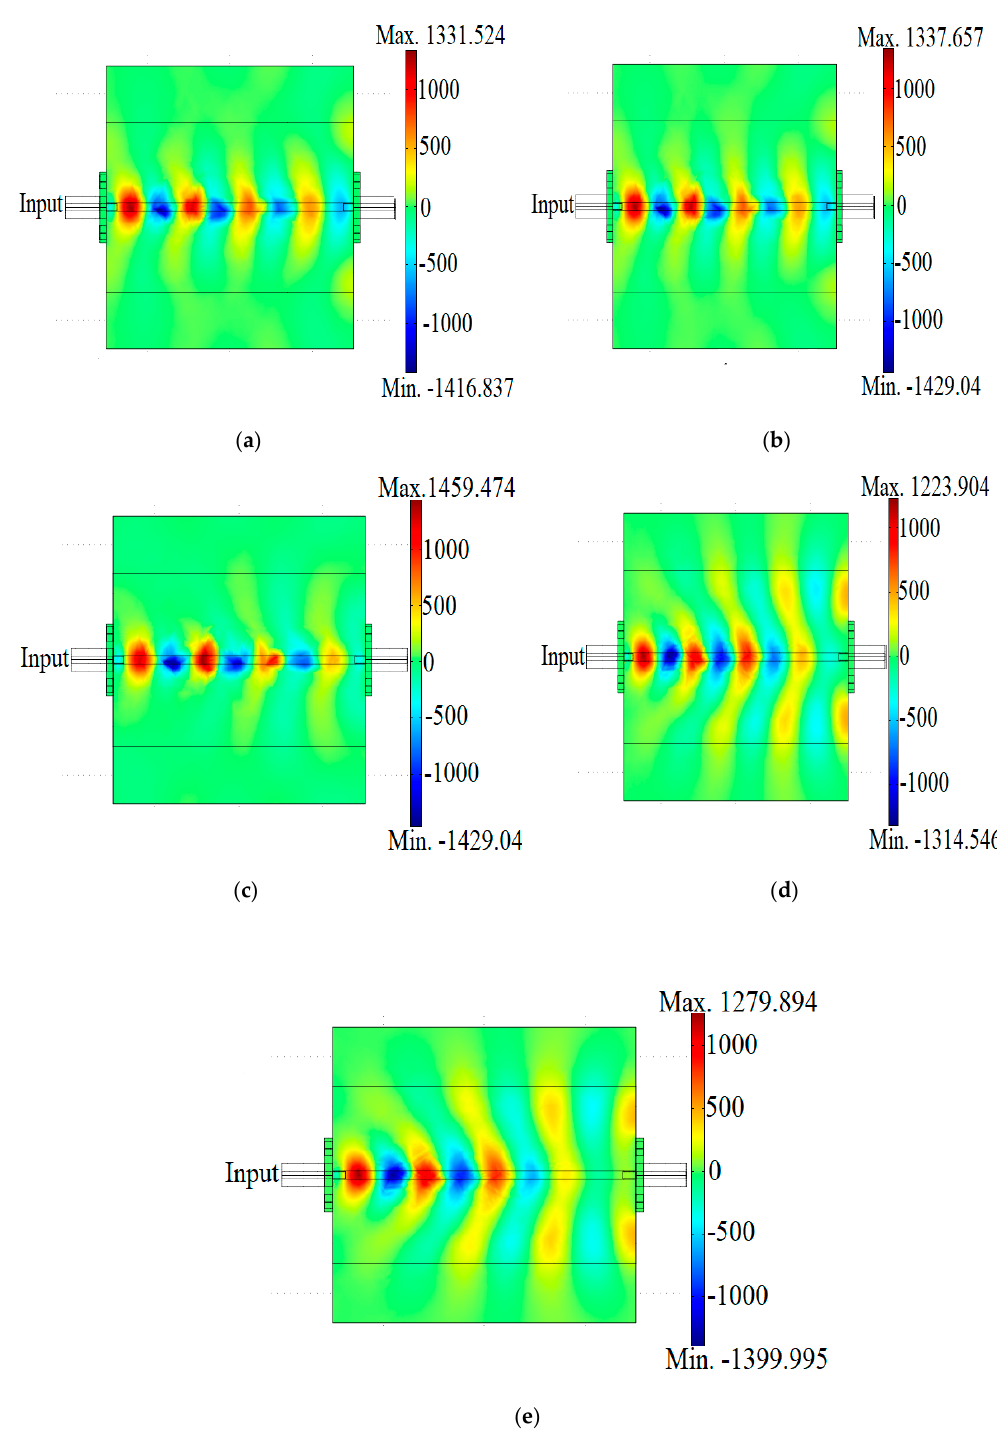
Figure 9. Electric field distribution patterns for OPEFB / PLA / MWCNT nanocomposites: ( a ) 6%; ( b ) 10%; ( c ) 14%; ( d ) 18%; ( e ) 22% MWCNTs.